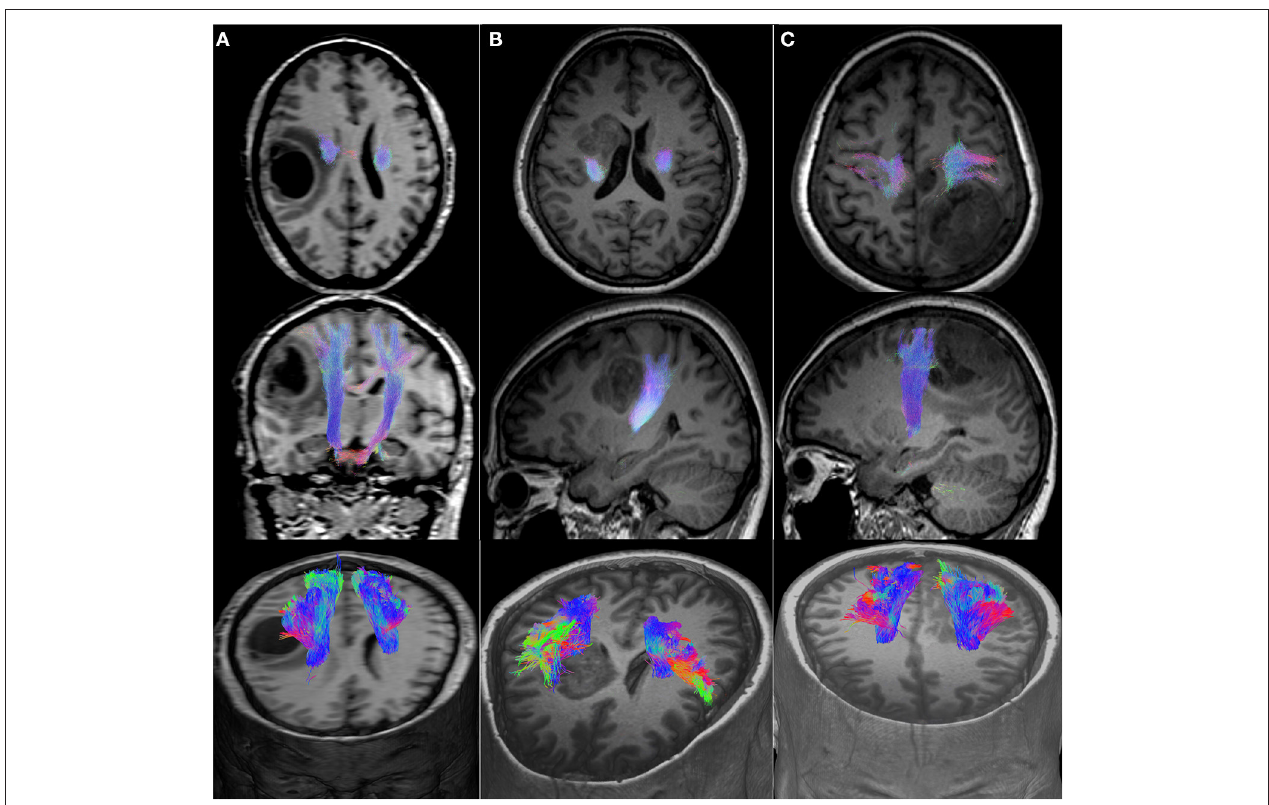
FIGURE 2 | Motor CST displacement. (A) , Axial, coronal, and 3D view of a medial displacement of the CST. (B) , Axial, sagittal, and 3D view of a posterior displacement of the CST. (C) , Axial, sagittal, and 3D view of an anterior displacement of the